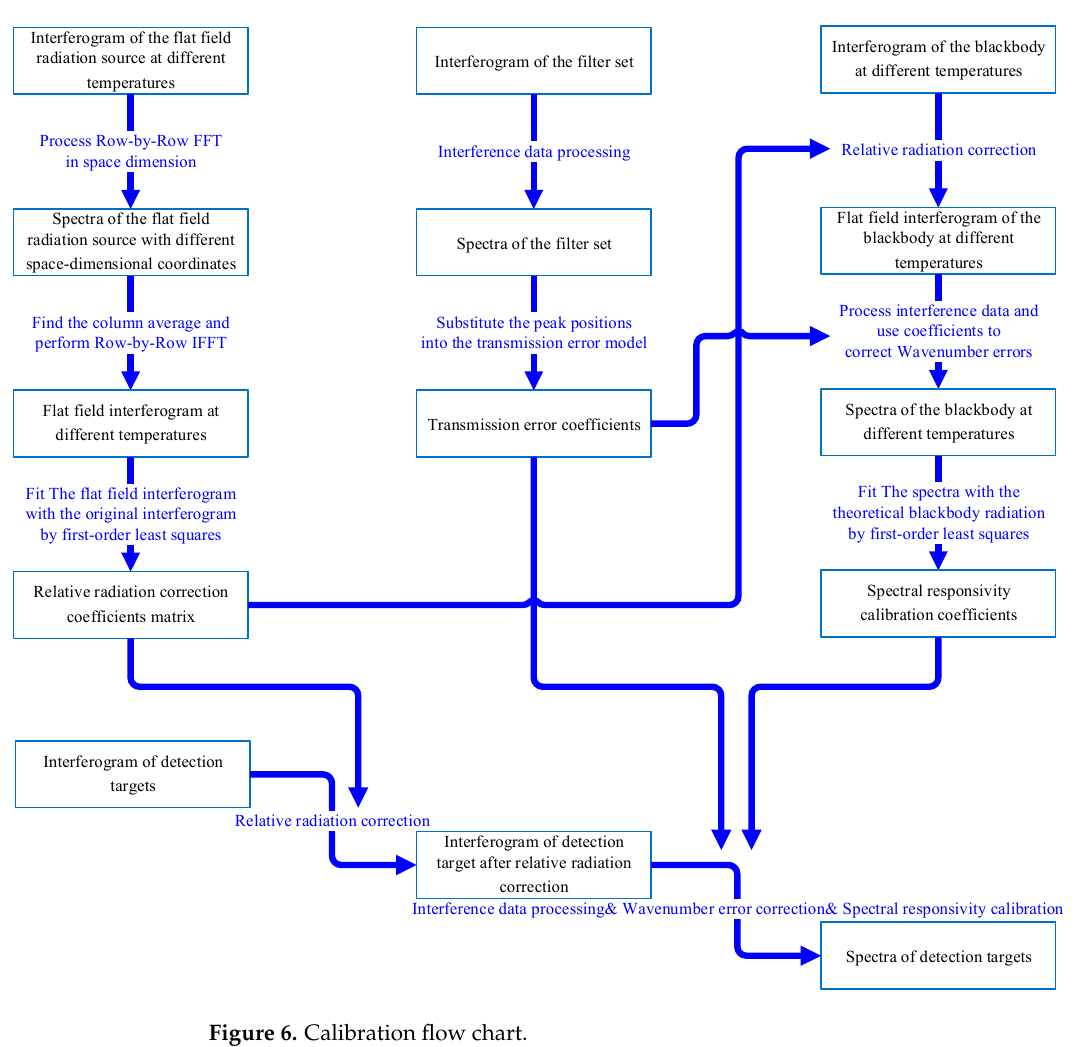
Figure 6. Calibration flow chart.